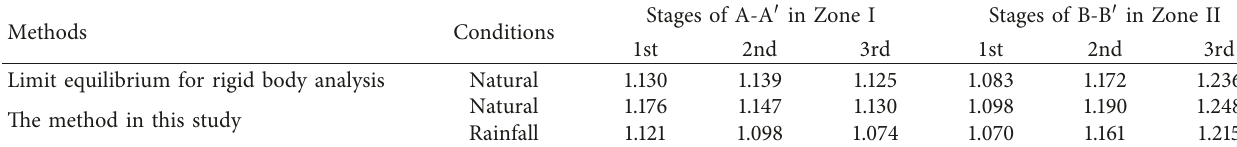
Table 2: Safety factors of the Zhenggang landslide deposit in natural and rainfall conditions.